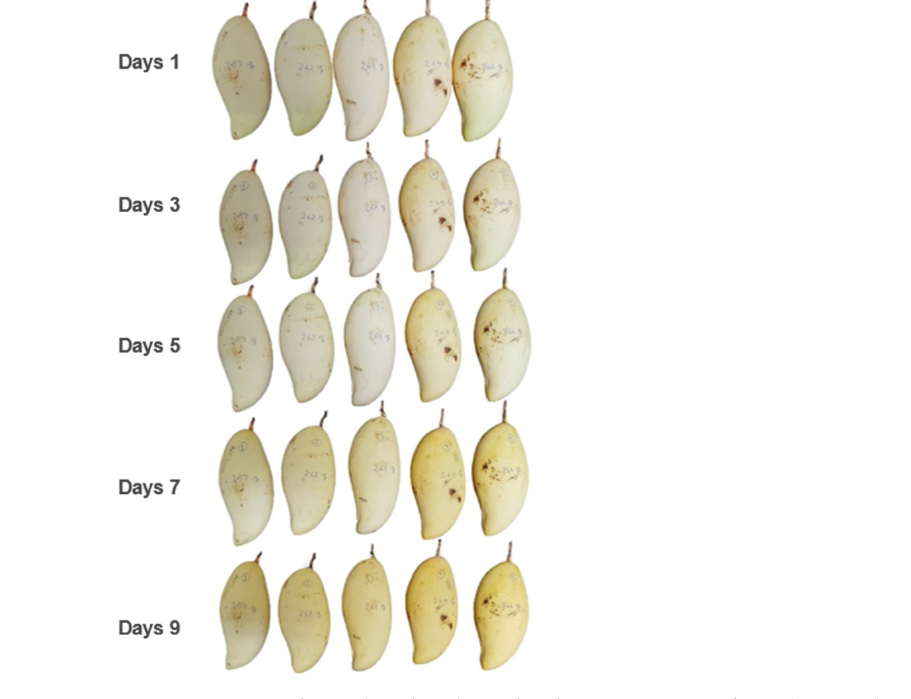
Figure 4. Images of samples of 80 days after fruit set mangoes from day 1 to day 9 after harvest. Table 3. The average and standard deviation for biochemical, physical, and electrical properties of 100 mango samples.